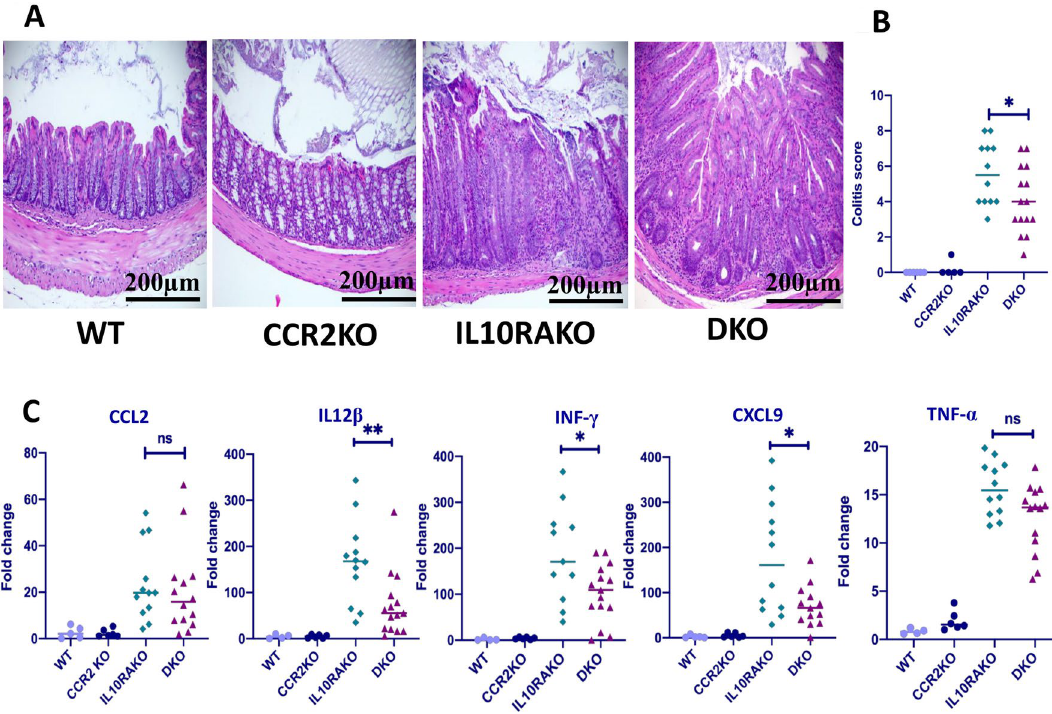
Figure 1. Loss of CCR2 decreases the severity of colitis in IL10RA-deficient mice. ( A ) Representative histological images (H&E) from the colons of 4- to 5-week-old mice of the indicated genotypes (WT = Cdcs1 +/+ I l10ra + /- Ccr2 + /- ; CCR2KO = Cdcs1 + / + Ccr2 − / − ; IL10RAKO = Cdcs1 + / + Il10ra − / − ; and DKO = Cdcs1 + / + Il10ra − / − Ccr2 − / − ). 20 × magnification, scale bar 200 μm. ( B ) Histology scores (0–15) in groups of WT (n = 4), CCR2KO (n = 6), IL10RAKO (n = 12) and DKO (n = 15) mice. ( C ) Colonic gene expression in mice of the indicated genotype determined by RT-PCR. Fold-change indicates ΔΔCT compared to a selected WT mouse. The results are pooled from 5 separate